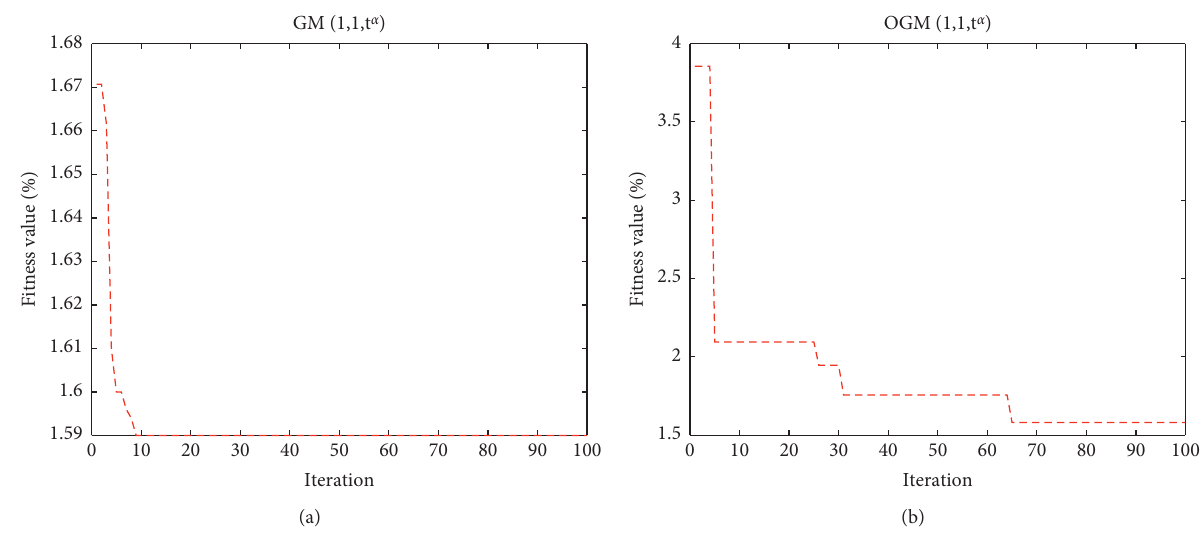
Figure 4: Track of seeking for the optimal parameters of the GM(1,1, t α ) model (a) and the novel model